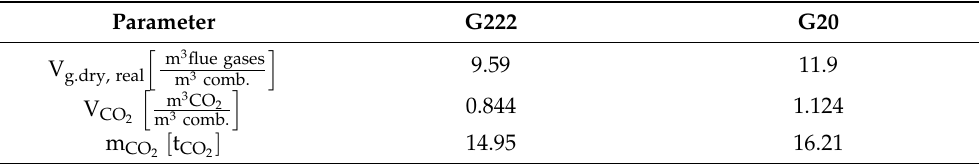
Table 8. Calculated values resulted from experimental